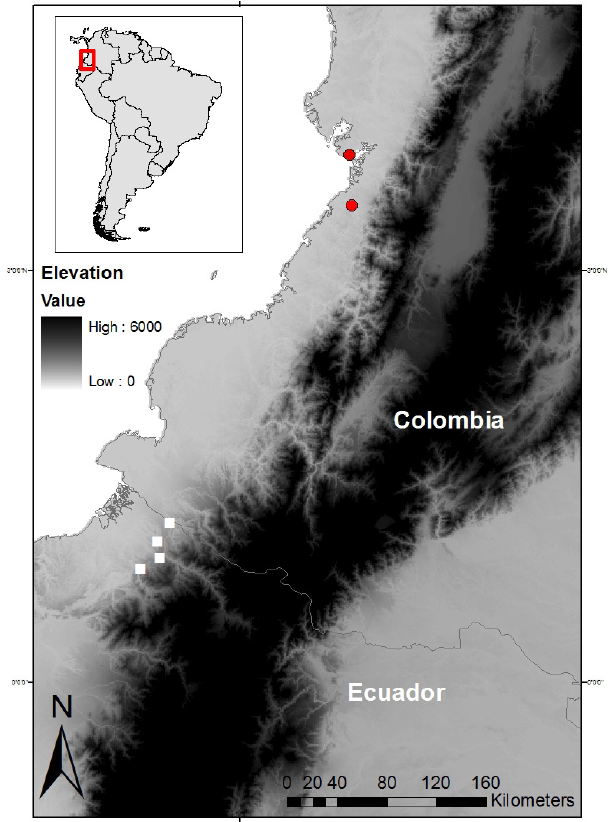
Imantodes chocoensis Figure 1. I. chocoensis Distribution map of . The white square represents the known distribution of in Ecuador; red circles show the new localities from